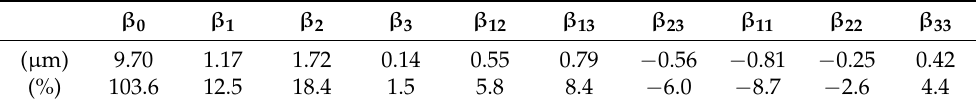
Table 6. Regression coefficients for the Ra response considering x 1 , x 2 , x 3 (in codified units) and f out in µ m and percentage over the mean Ra value.